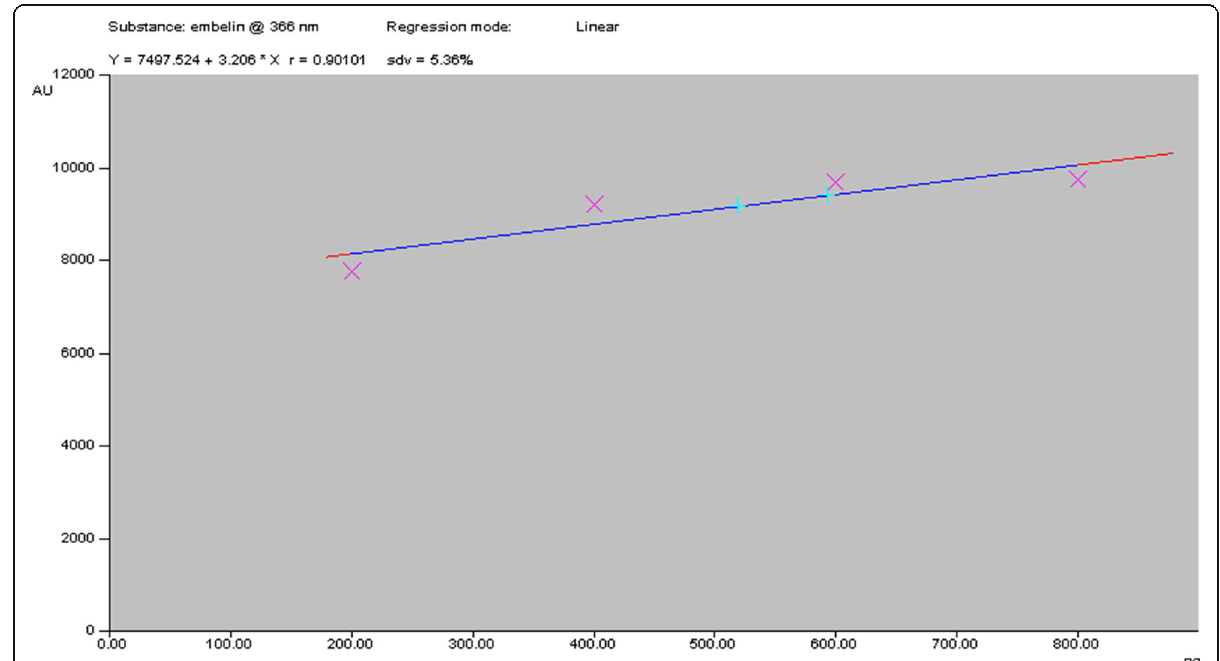
Fig. 2 Calibration curve of standard embelin at 366